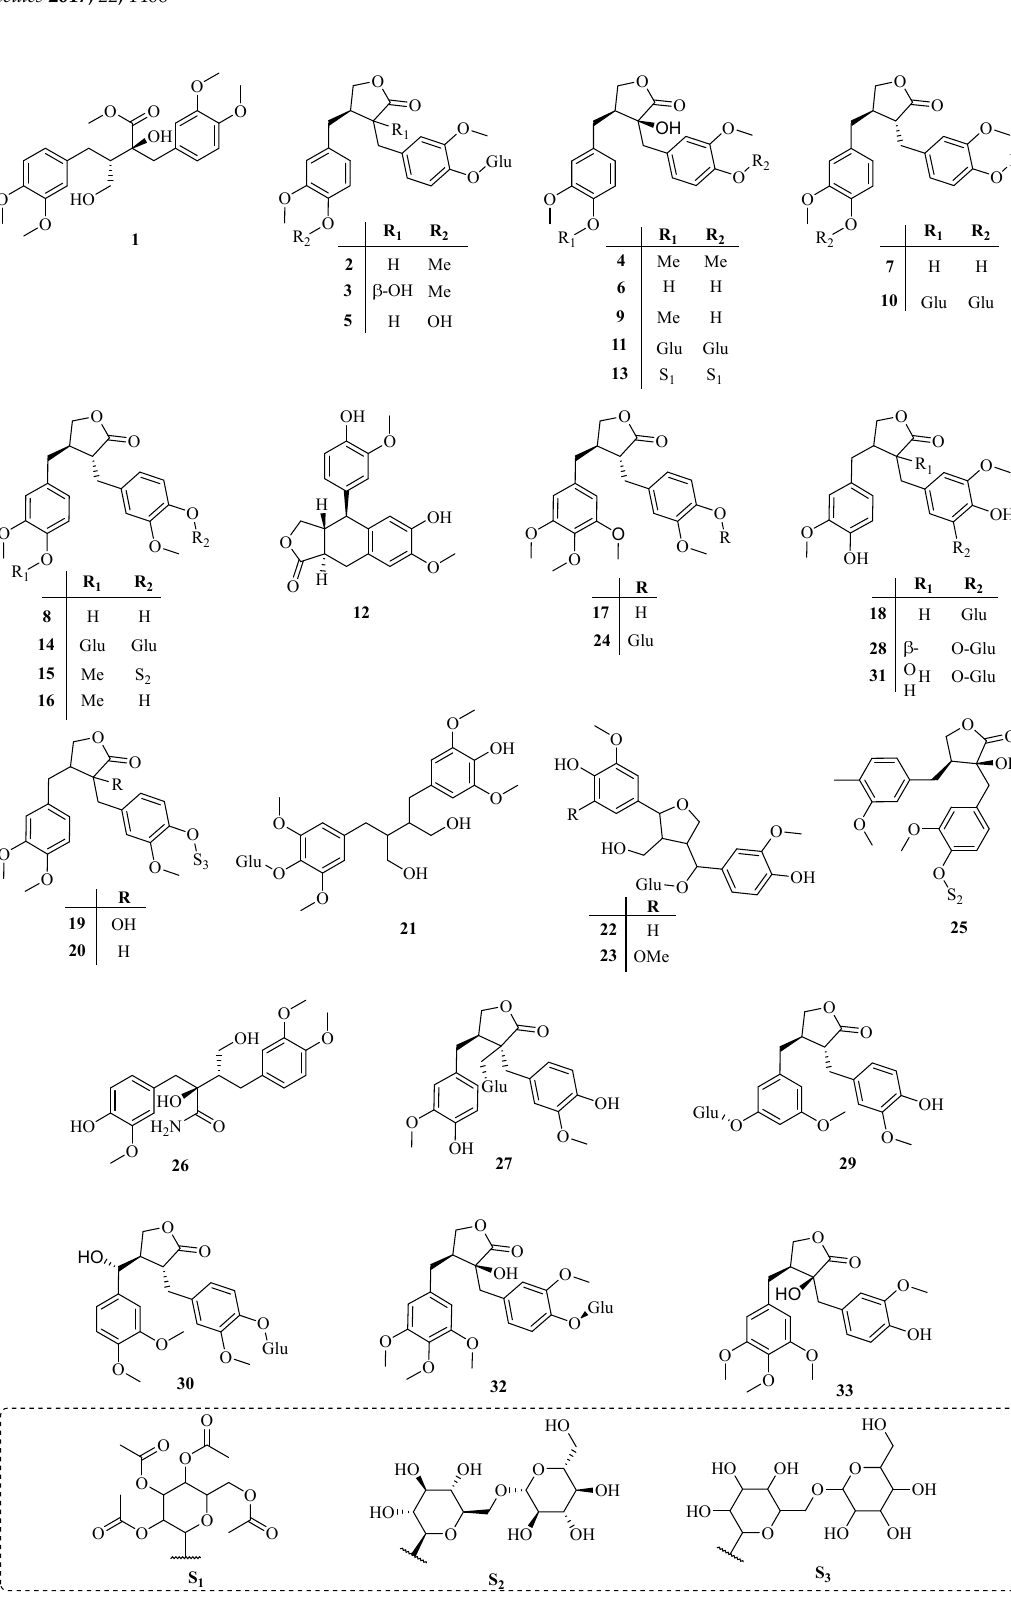
Figure 2. Lignans from the genus Trachelospermum.